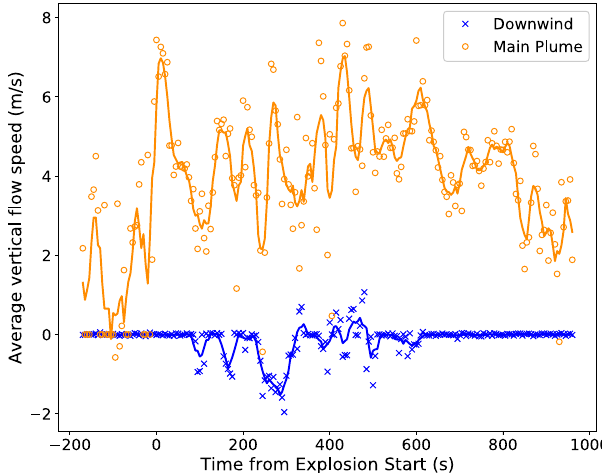
Figure 4. Average vertical flow speeds for the main plume (orange circles) and downwind (blue crosses) regions. The x-axis is the time with respect to the onset of the explosion, determined from the imagery. Positive velocities correspond to upwards motion. The solid lines represent the 5 point moving